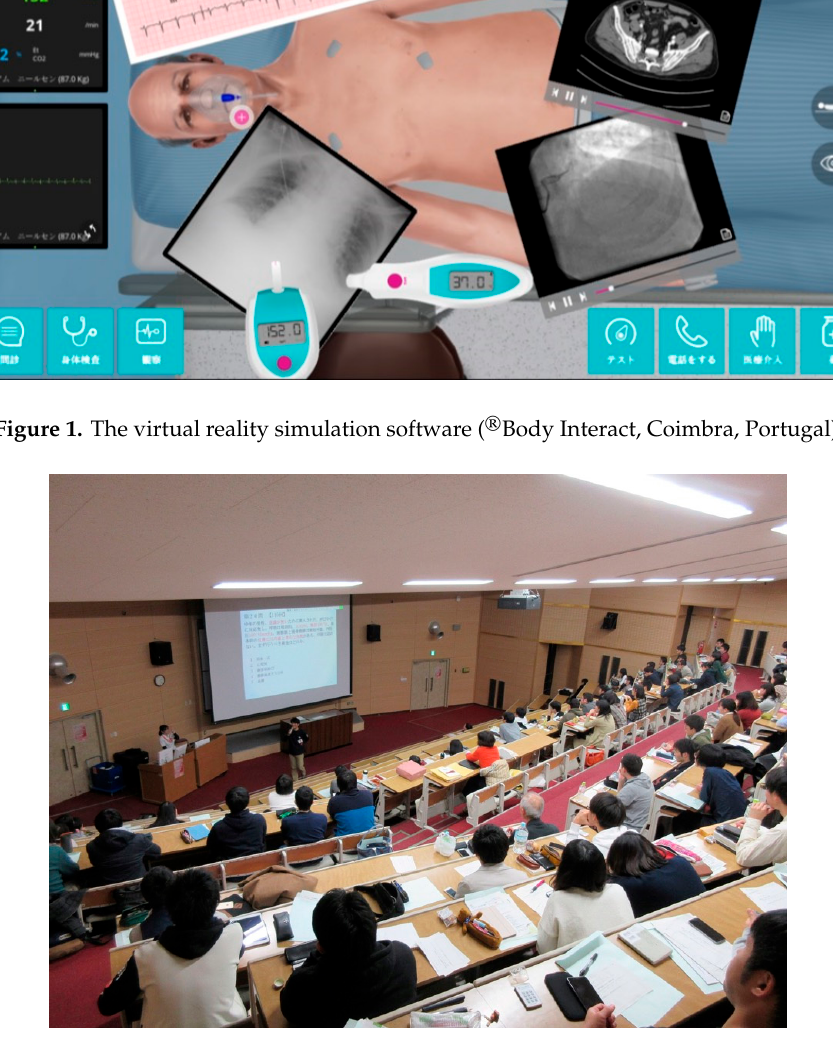
Figure 2. Clickers being distributed during the pre-test (March 2018).